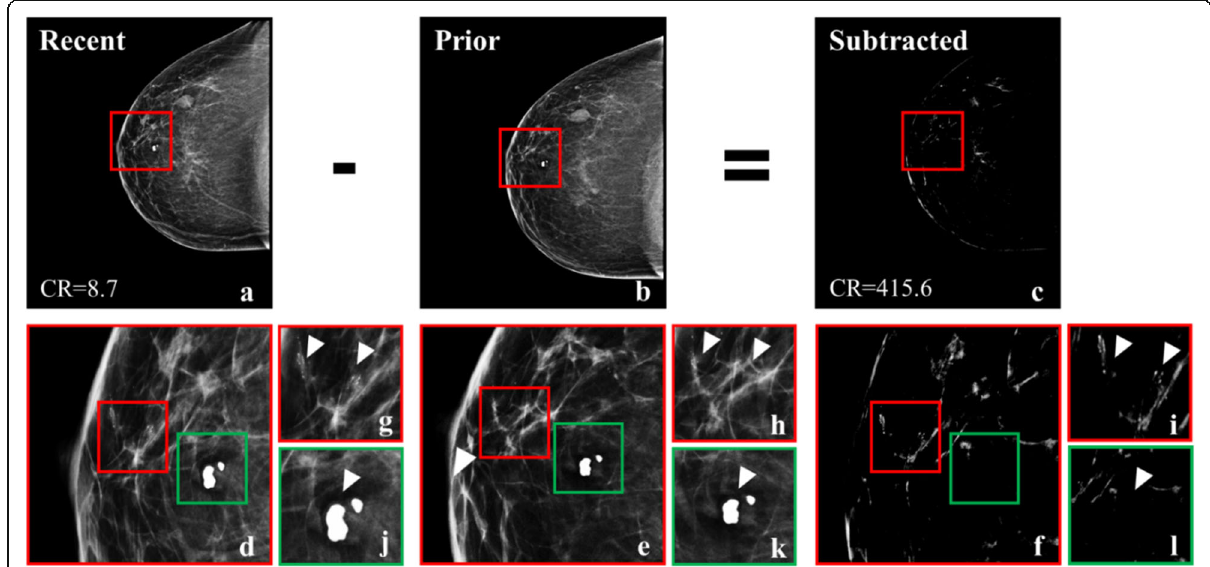
Fig. 4 Example of temporal subtraction in a woman (BI-RADS breast density class b ) with BI-RADS benign and suspicious microcalcifications. a Most recent mammographic view. b Prior mammographic view. c The result of subtracting the registered version of b from a , where the contrast ratio has increased 92 times after subtraction. d − f Zoomed regions marked by the red squares in a − c . g – i Zoomed regions marked by the red squares in d − f where the arrowheads point to new BI-RADS suspicious microcalcifications, which were not subtracted. ( j − l ) Zoomed regions marked by the green squares in d − f where the arrow points to pre-existing BI-RADS benign microcalcifications, which were completely subtracted. CR Contrast ratio